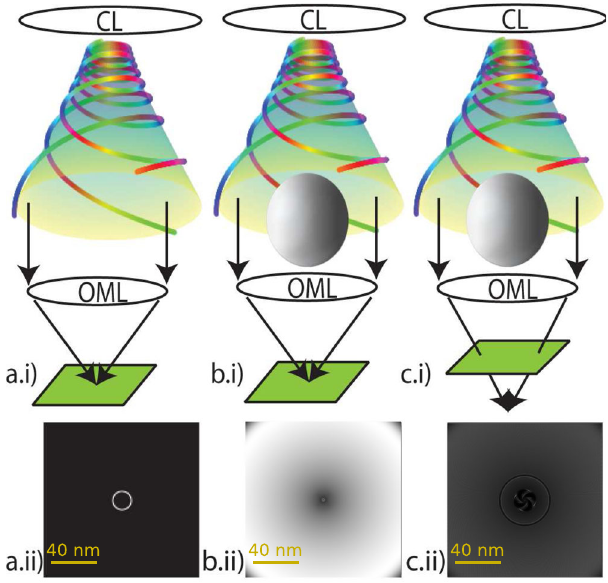
Fig. 2 A schematic of Fresnel contrast obtained from electron vortex beams. a .i, b .i and c .i schematics of the electron vortex beam (EVB) and electron beam con fi guration for three different defocus conditions. The EVB waist sits above the sample, so the beam is semi-convergent at the sample plane. The EVB waist is adjusted by the condenser lens (CL). The EVB divergence and the helical wavefronts are shown by the cone and colored paths, respectively: the color indicates the winding phase. The image focus is adjusted by the objective mini-lens (OML), which appears on a screen shown as the green plane. a .ii An in-focus image of the EVB without a sample. b .i An in-focus image of an EVB and a nanoparticle sample, in order to obtain near-uniform illumination across the image, the simulated transmission electron microscopy (TEM) image in b .ii is a composite of multiple exposures, each acquired by adjusting the beam crossover-point and thus performing a longitudinal scan of the electron vortex beam over the sample. c .ii A defocused image of an EVB and a nanoparticle sample obtained by summing a series of images. In b .ii and c .ii the image is composed of multiple exposures obtained while adjusting the relative distance between the beam waist and the